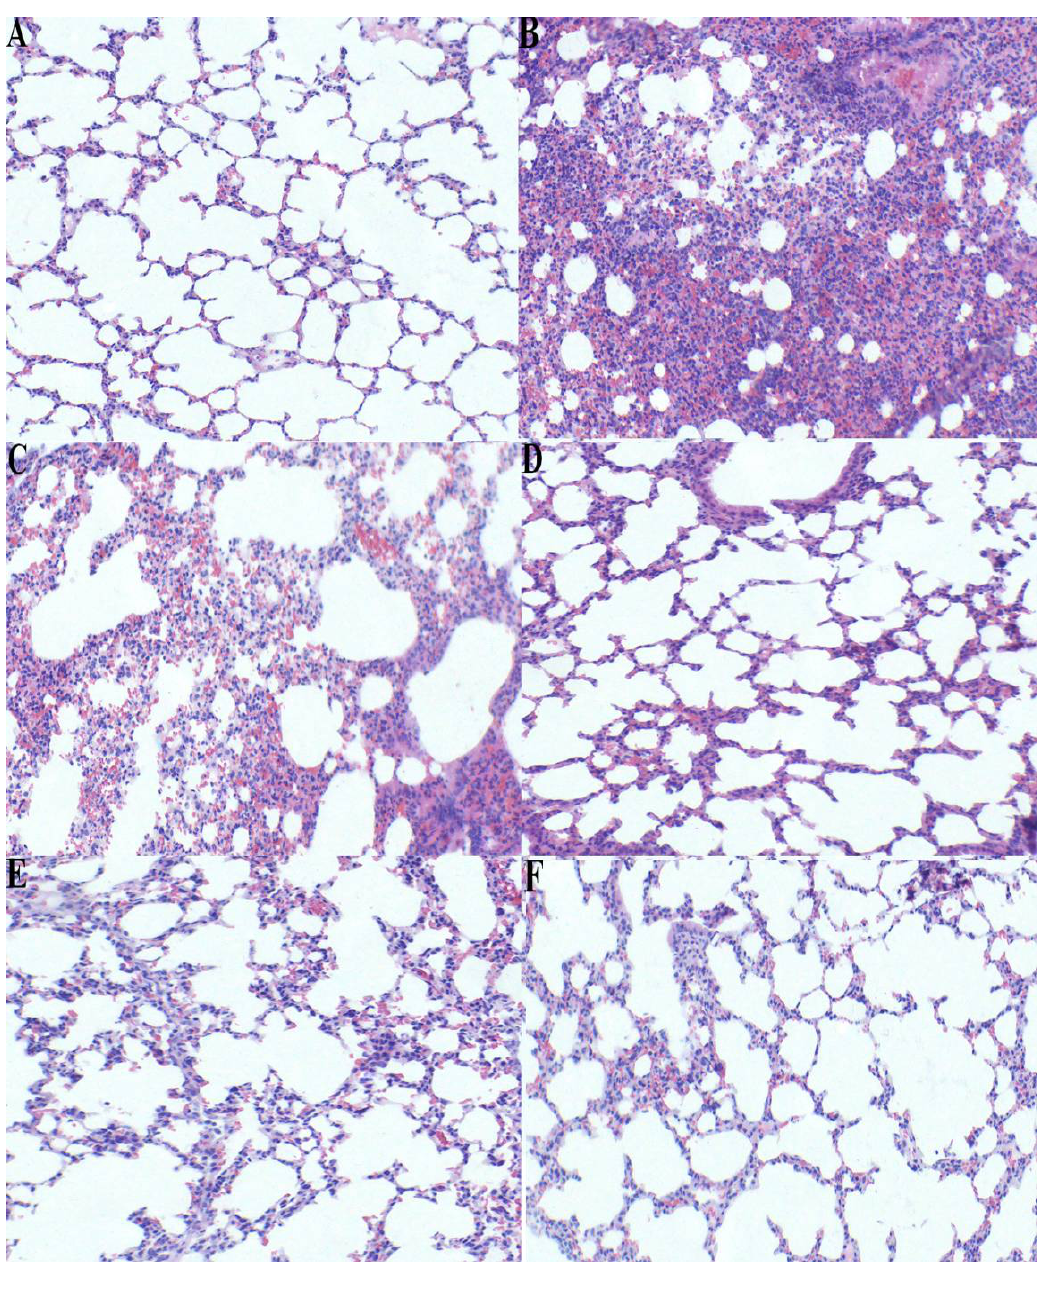
Figure 6. Effect of p -cymene on histopathological changes in lung tissues in LPS-induced ALI mice (×100). Mice were given a intraperitoneal injection of p -cymene (25, 50, 100 mg/kg) 1 h prior to an i.n. administration of LPS. Lungs (n = 3) from each experimental group were processed for histological evaluation at 7 h after LPS challenge. Lungs were prepared for H&E staining. Control group ( A ): microphotograph showing normal structure of the lung. LPS group ( B ): microphotograph showing histopathological changes (focal thickening, congestion) of the lung. p -Cymene group ( C , D , E ) and DEX group ( F ): microphotograph showing decreased histopathological changes of the lung. A, B, C, D, E and F magnification